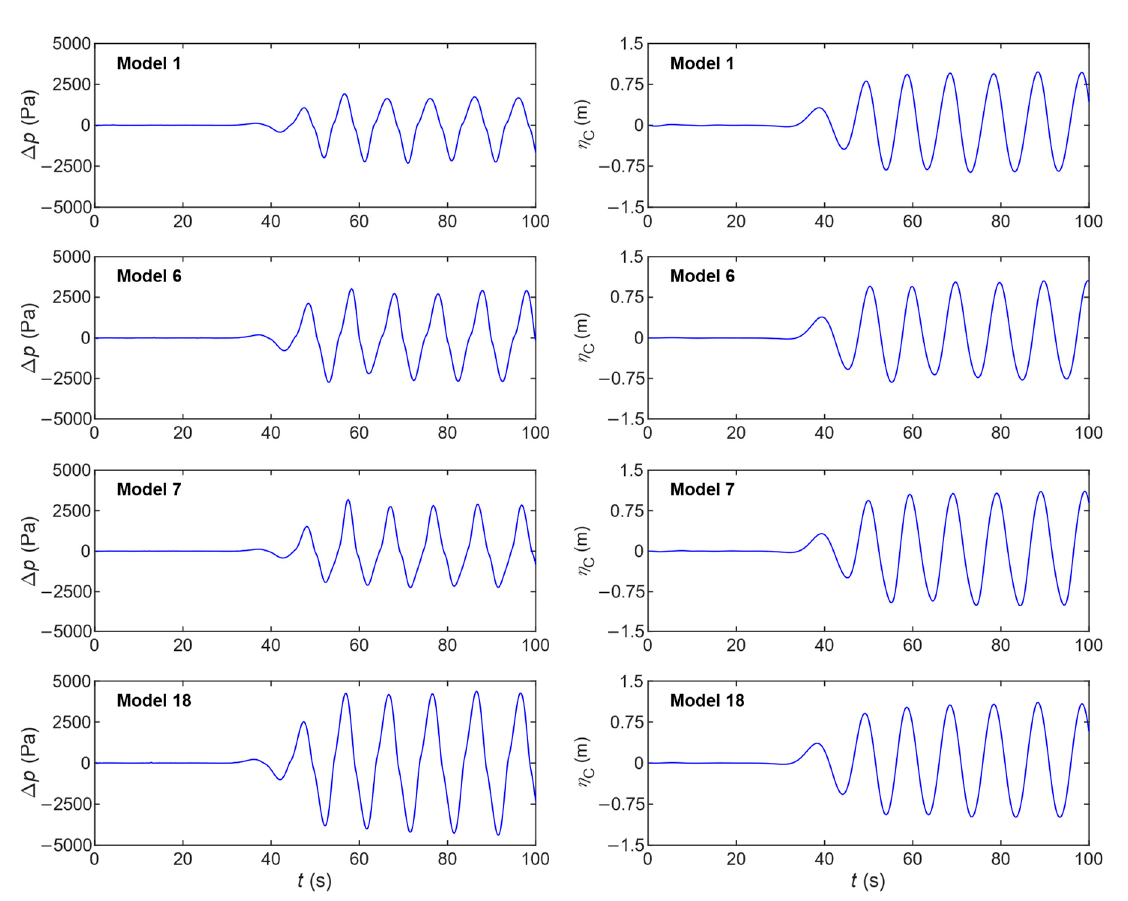
Figure 9. Pressure drop (left-hand panels) and free surface elevation (right-hand panels) time series scaled up to prototype dimensions for the OWC designs 1, 6, 7 and 18, for a wave condition with H = 1 m and T = 10 s. Table 1. Maximum values of (i) the response amplitude operator of the oscillations of the water column inside the chamber ( RAO C ), (ii) and the response amplitude operator of the pressure oscil- lations ( RAO P ), and (iii) the capture width ratio ( C WR ), for the different OWC geometries tested ( H = 1 m). Model RAO C, max RAO P, max